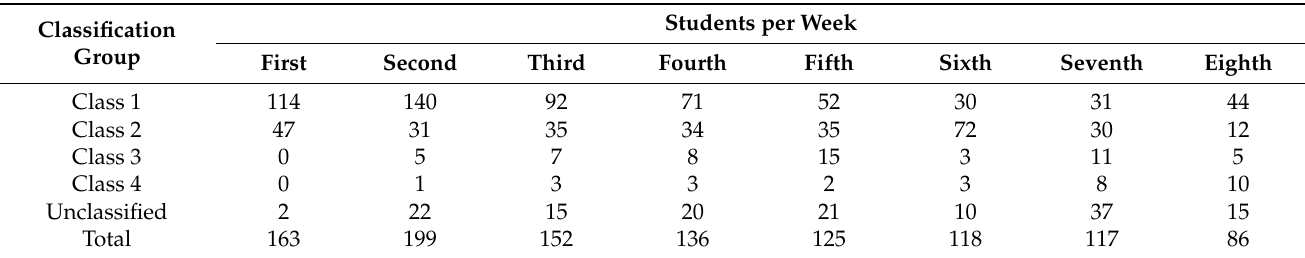
Table 2. Expert classification of students for different